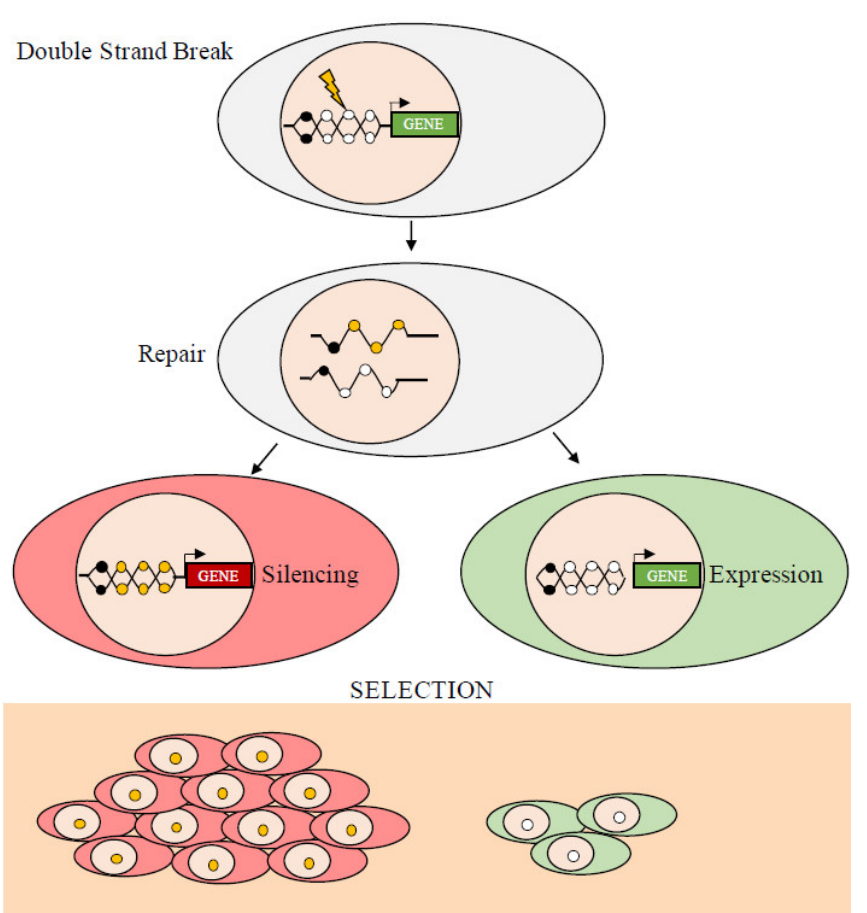
Figure 3. Double strand break (DSB) and homologous repair (HR) edit local methylation. Schematic representation of the events leading to the silencing or expression of DNA segments following DBS and HR. The yellow circles represent de novo methylated CpGs in HR clones. The black circles represent previously methylated CpGs. DNA damage and subsequent methylation are random, while gene silencing depends on the location of the methyl Cs. If the expression of the repaired gene is harmful, only cells that inherit the muted copy will survive. Conversely, if the function of the repaired gene is beneficial, the cells inheriting the non-methylated copy will have a growth advantage.